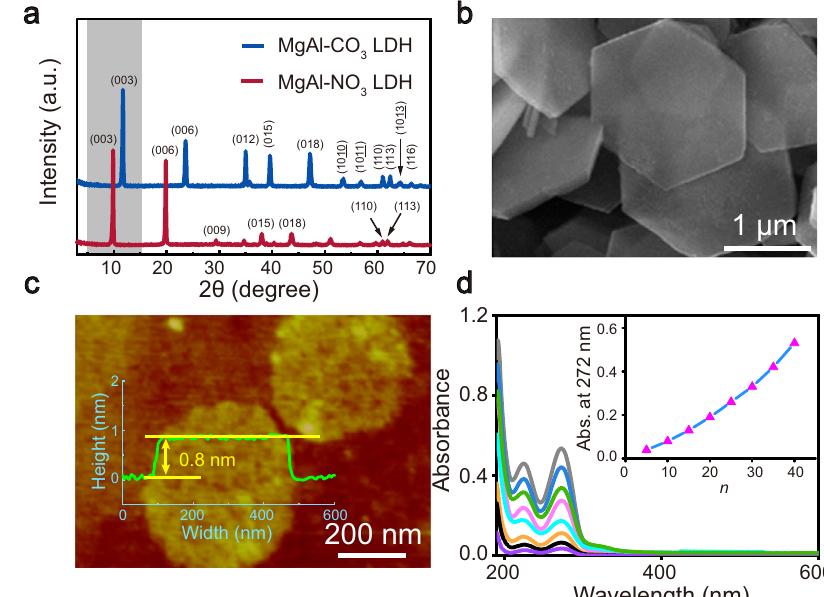
Fig. 2 Characterisation of LDH nanosheets and LBL assembly of (LDH/FAS) n membranes. a XRD patterns of MgAl(CO 3 )-LDH and MgAl(NO 3 )-LDH. b SEM images of MgAl(NO 3 )-LDH. c Tapping-mode AFM image and height pro fi les of single-layer MgAl-LDH nanosheets. d UV – Vis absorption spectra of the (LDH/FAS) n membranes (inset: the approximately linear relationship between absorbance at 272 nm and bilayer number n